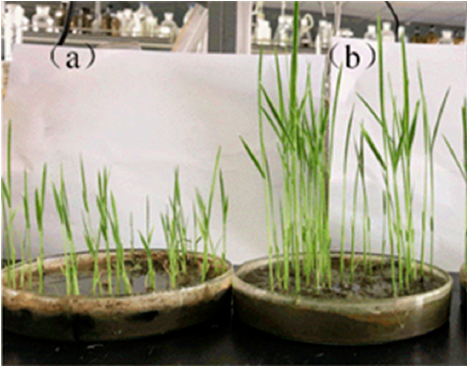
Figure 5. Rice cultivated: ( a ) in original soil; ( b ) in soil washed with [Gly][Cl].